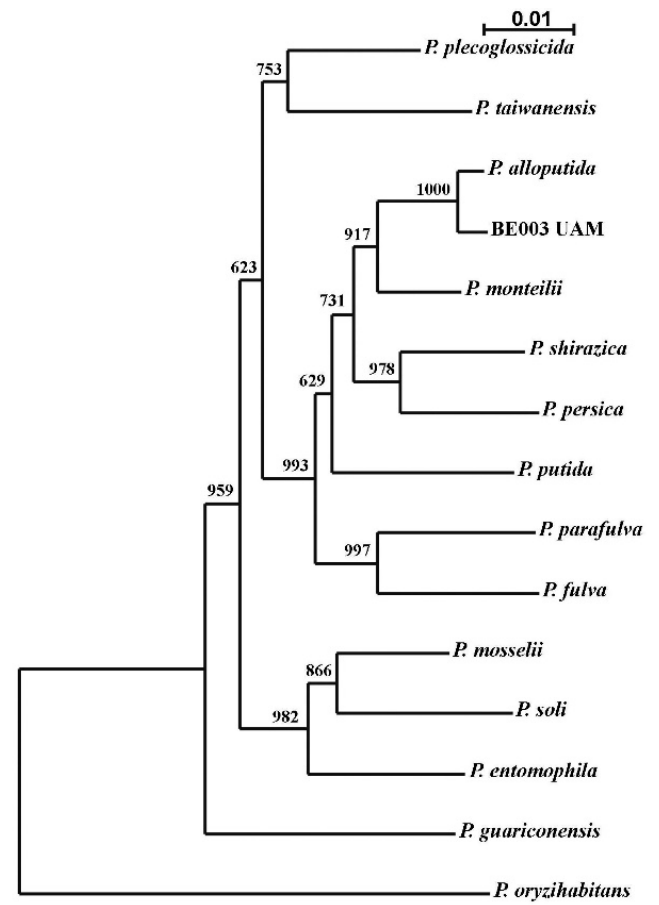
Figure 1. Neighbor-joining phylogenetic tree for assignment of the isolate B003 UAM to Pseudomonas alloputida species. Sequences from the type strains of each species were used. Numbers are bootstrap values of the corresponding branching points. The bar indicates the scale of phylogenetic distances of the branches.